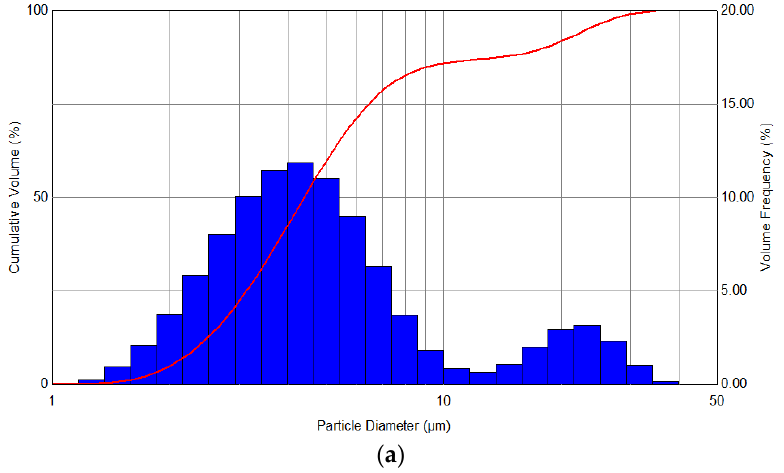
Figure 4. Diameter distribution spectra of the aerosol droplets obtained by spraying at a pressure of 2 bar: ( a ) without heating, ( b ) with heating.